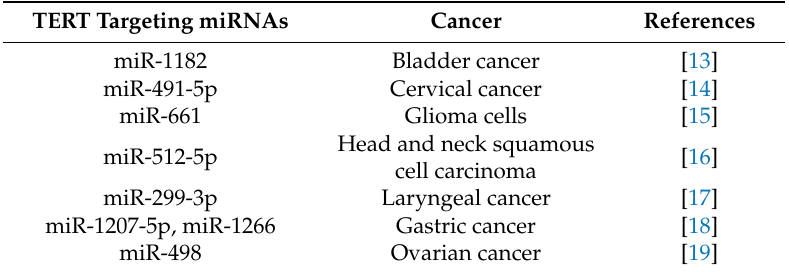
Table 1. miRNAs involved in TERT regulation in different